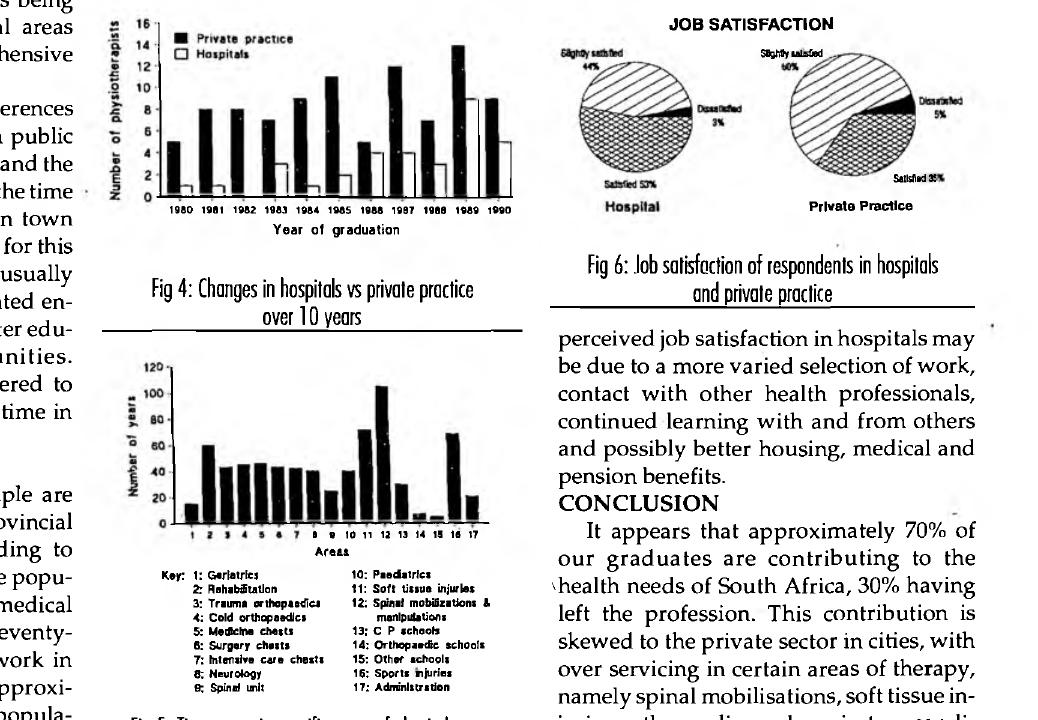
Fig 5: Time spent in specific areas of physiotherapy administration. Areas found to be rela­